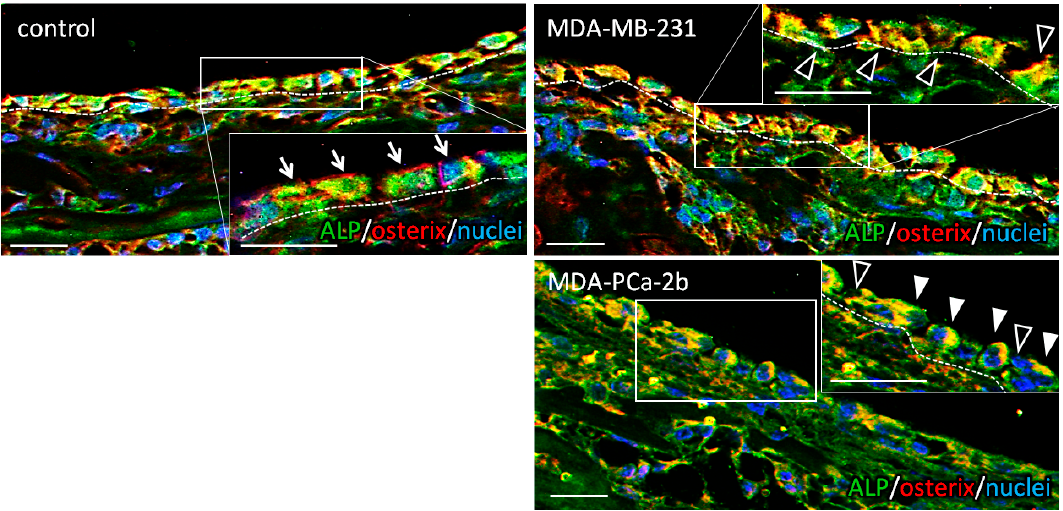
Figure 3. Immunohistochemical images of the bone surface cultured without tumor cells (control), with breast cancer MDA-MB-231 cells, and prostate cancer MDA-PCa-2b cells. Insets show magnified images. Green; ALP (alkaline phosphatase), Red; osterix, Blue; nuclei. Arrows indicate the ordered osteoblasts in control. Black arrowheads show disrupted intercellular connection; white arrowheads indicate the abnormal morphology of osteoblasts. Dot lines indicate the bone surface. Scale bars: 20 µm.